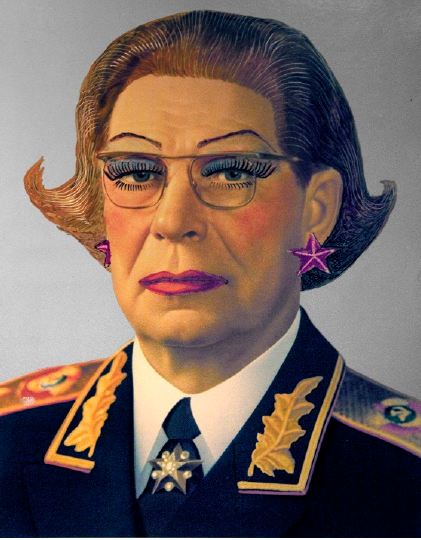
Figure 3. Vlad Mamyshev-Monroe. From the series “Politburo” (2011). D.F Ustinov. https://vmmf.org/series/view?id=16#work-series-16-2 (accessed on 11 September 2022).